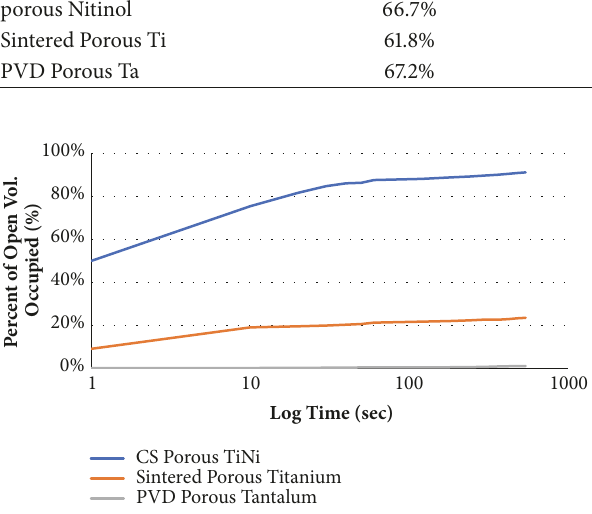
Figure 9: Porous Nitinol, Sintered porous Ti, and PVD porous Ta wicking PBS solution as a percentage of open pore volume over 10